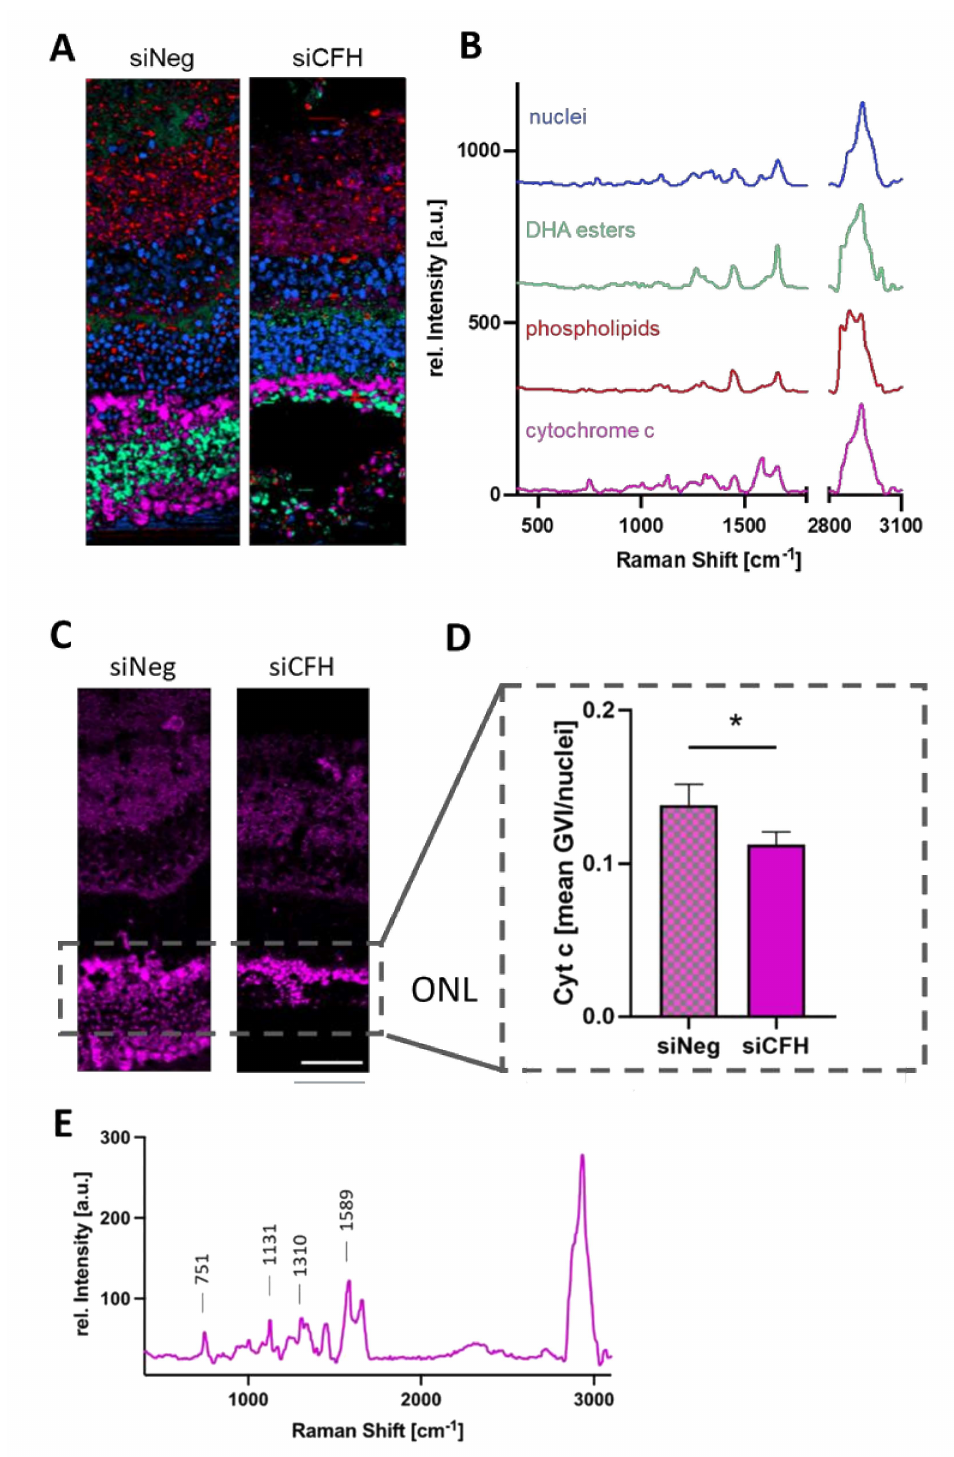
Figure 3. ( A , B ) True component analysis (TCA) was performed on the spectral maps of siNeg and siCFH samples to generate intensity distribution heatmaps ( A ). According to different spectral signatures ( B ), pixels assigned to nuclei (blue), cytochrome c (pink) and two different lipid com- ponents (red and light green) could be identified and localized. ( C , D ) Quantitative analysis of the mitochondrial activity of the ONL region based on the cytochrome c intensity distribution images ( C ) and calculation of the mean GVI/cell ( D ). ( E ) Raman signature of the mitochondrial activity TCA component. ONL—outer nuclear layer, siNeg—silencing negative control, siCFH—silencing CFH. Data are presented as mean ± SD. N = 3 biological replicates. * p ≤ 0.05; Scale bar—50 µ